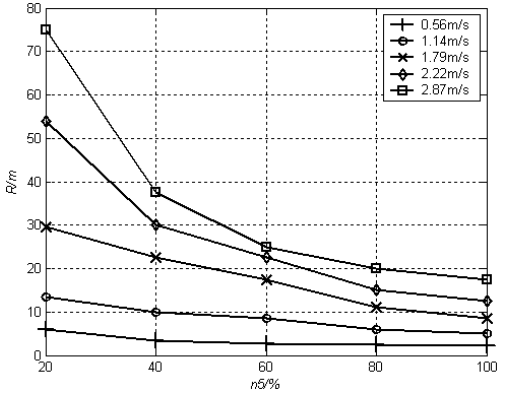
Figure 28. Experimental turning radius at different speed.